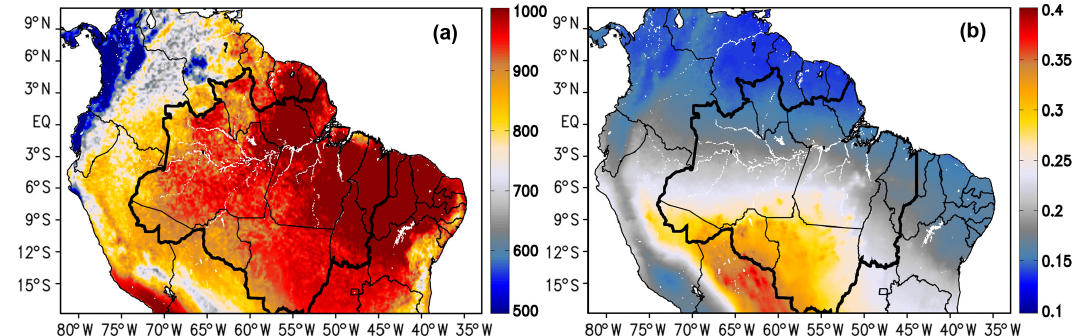
Figure 11. (a) Mean PAR (µmolm − 2 s − 1 ) at 16:00UTC for September 2010 from the DIR+DIF experiment and (b) the mean diffuse fraction of solar radiation at 16:00UTC for September 2010 as simulated by DIR+DIF. The darker black contour line on the maps delimits the LBAR.